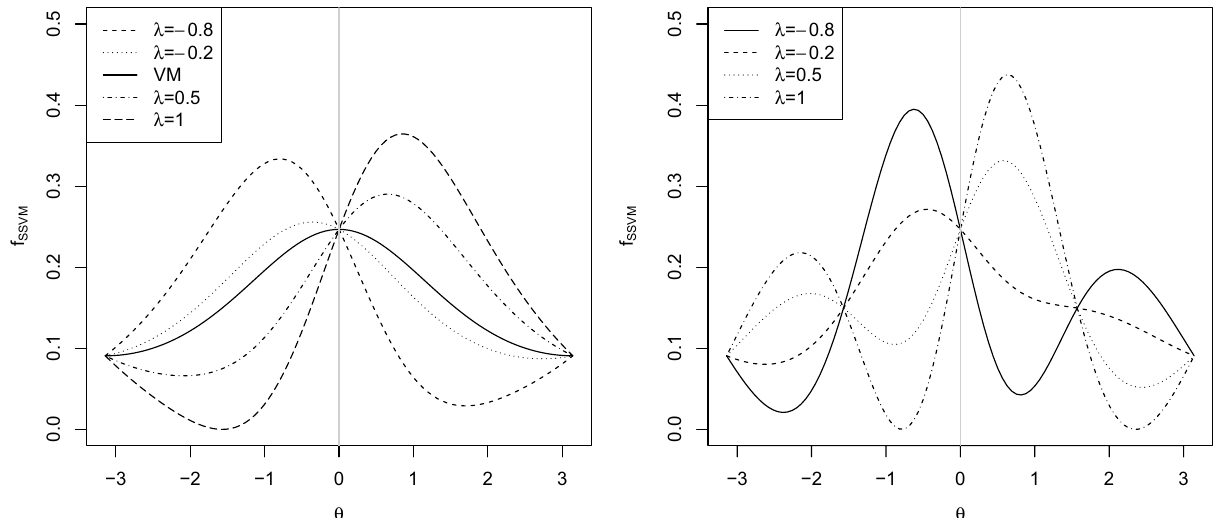
Figure 5. Density functions of the SSVM for τ = 0.5 , µ = 0 , (cid:31) = − 0.8, − 0.2, 0.5, 1 and k = 1 (left) and k = 2